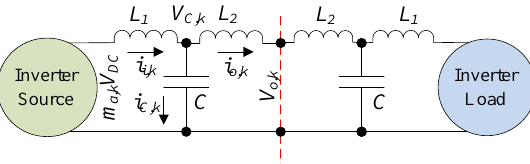
Figure 6. LCL filter for multi-channel inverter.